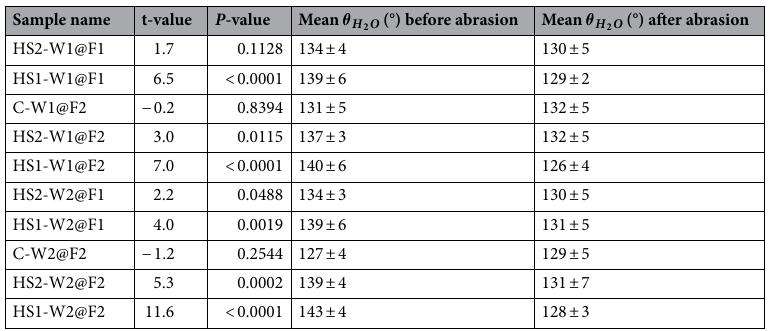
Table 4. The t-values and P -values of the paired t-test performed on the contact angle measurements before and after abrasion.